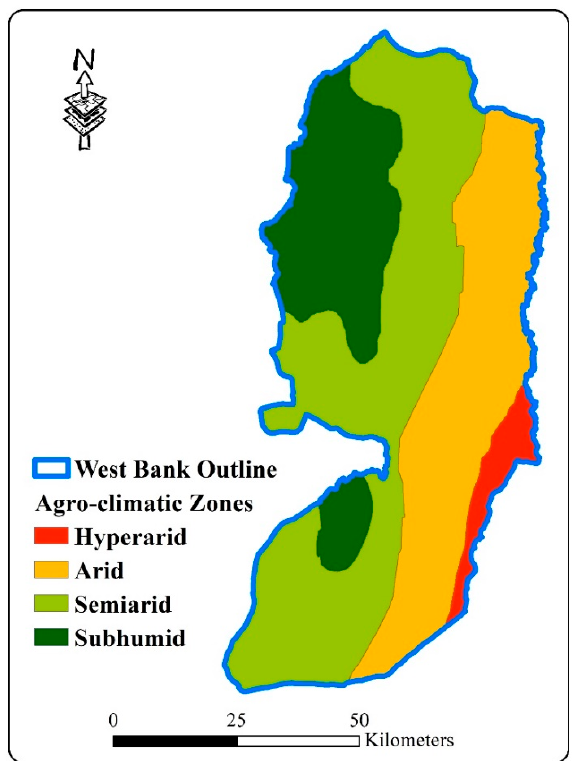
Figure 2. Agro-climatic zones in the West Bank.